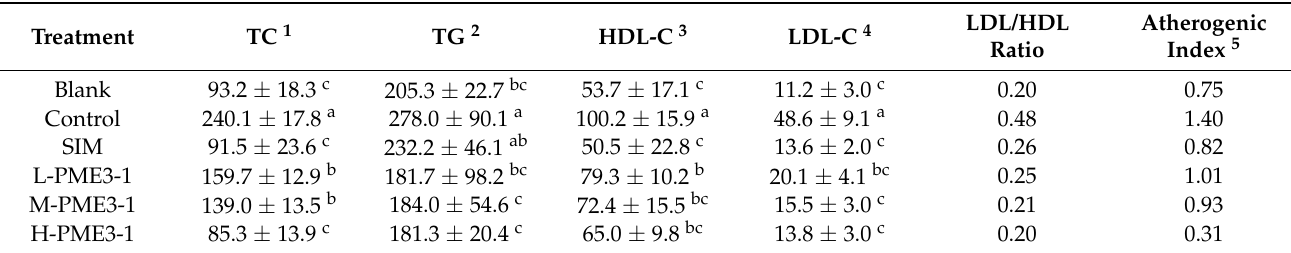
Table 3. Effects of PME3-1 on serum biochemical index of hamsters fed with high fat and choles- terol